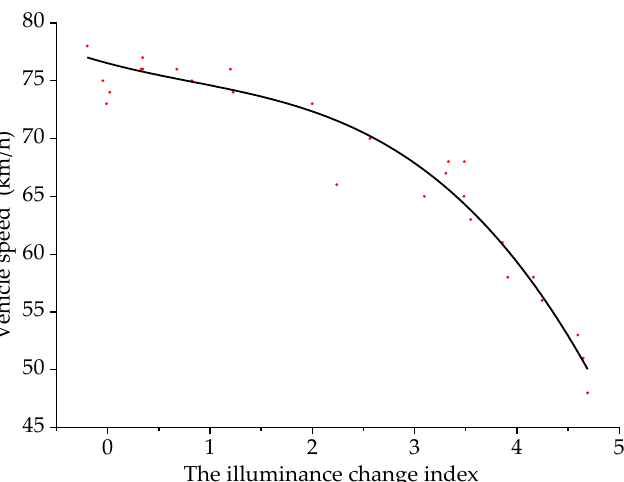
Figure 7. Fitting curve of illuminance change index and vehicle speed.